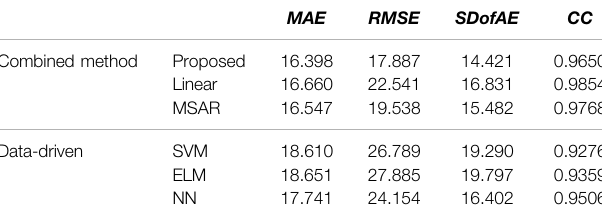
TABLE 2 | Wind power prediction using various